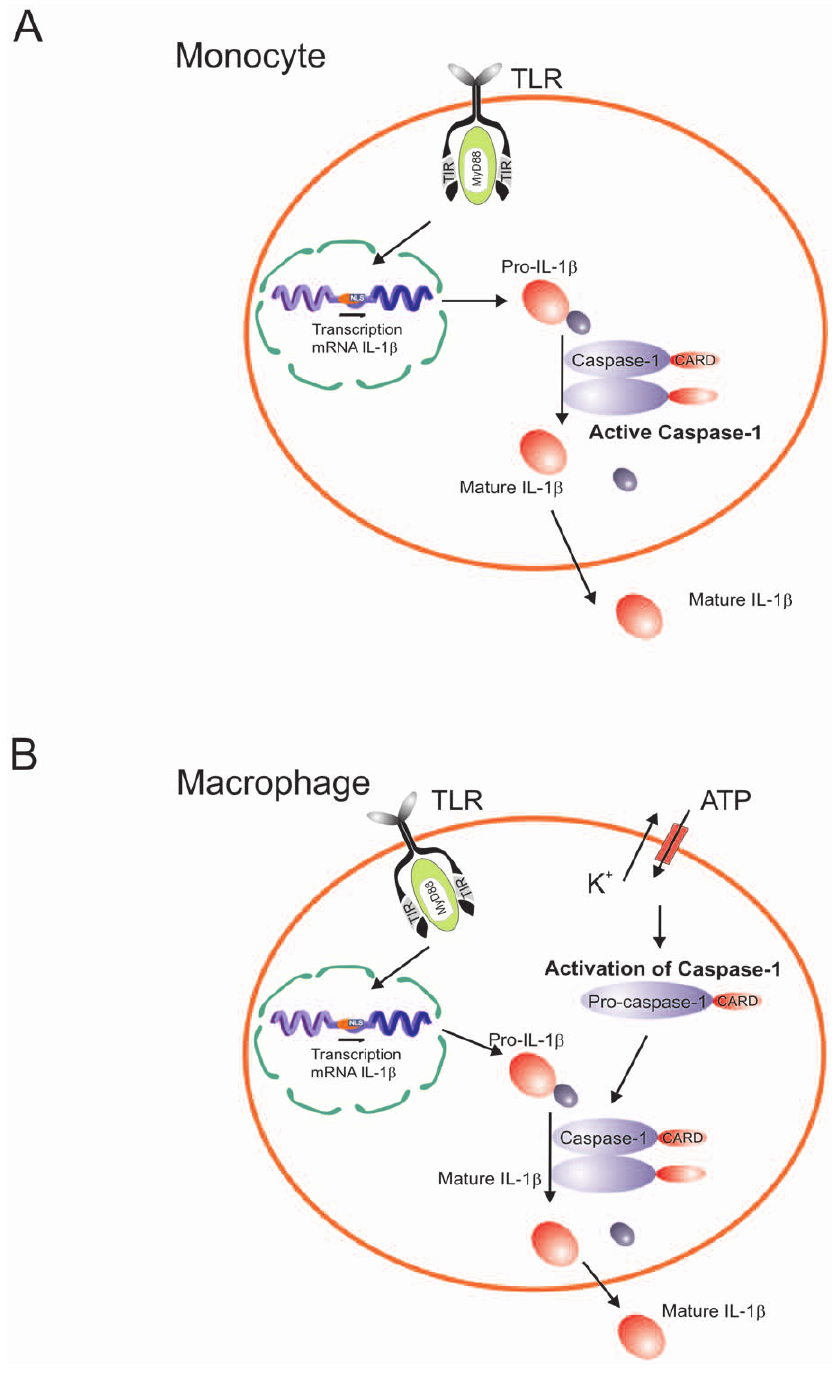
Figure 2. Diagram representing the differential caspase-1/IL-1 b activation pathways in monocytes and macrophages. Caspase-1 is constitutively activated in monocytes, and these cells release mature IL-1 b after single stimulation with TLR ligands. IL-1 b secretion is induced by endogenously-released ATP. In contrast, macrophages need a double stimulation: one stimulus (TLR-ligands) induces transcription, and a second stimulus (ATP) induces IL-1 b